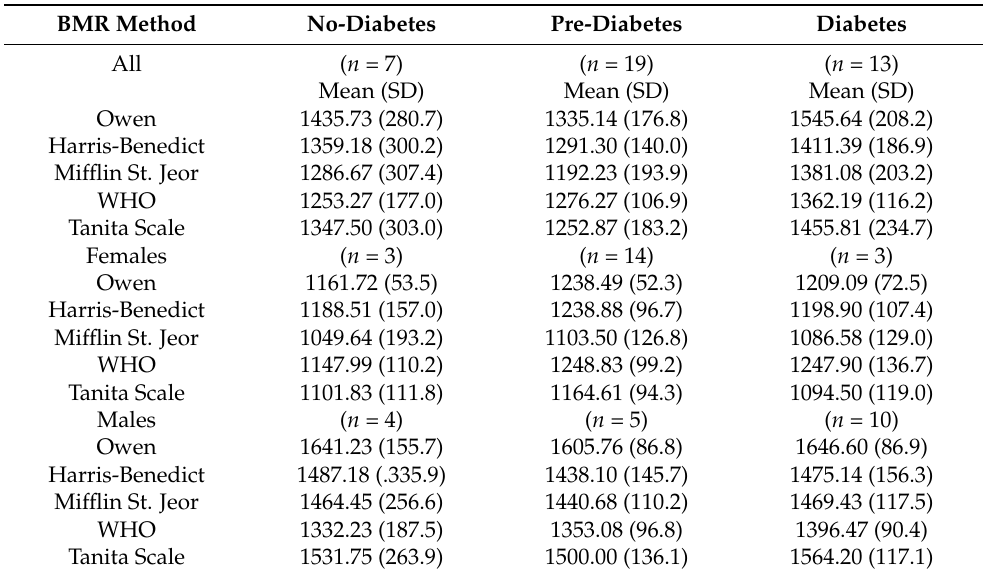
Table 2. Basal Metabolic Rate (BMR) Calculated Using Five Different Methods by Gender and Diabetes